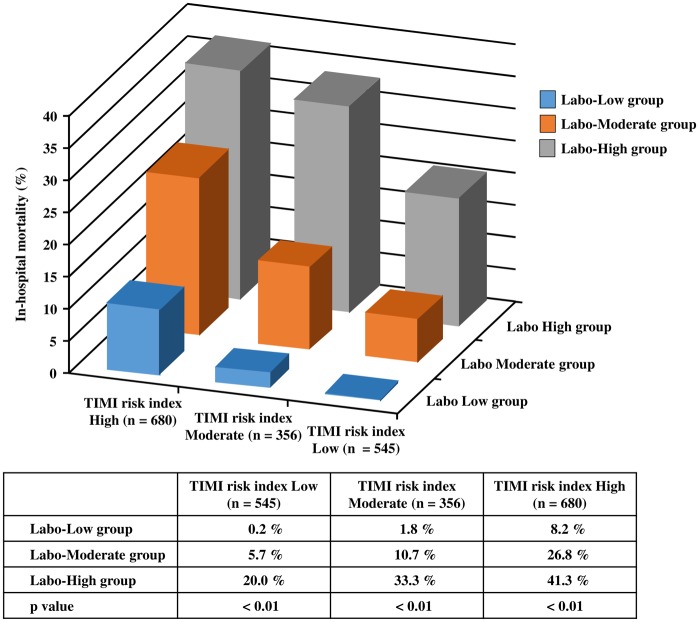
Subdivision by the laboratory risk in patients assessed with the TIMI risk index.